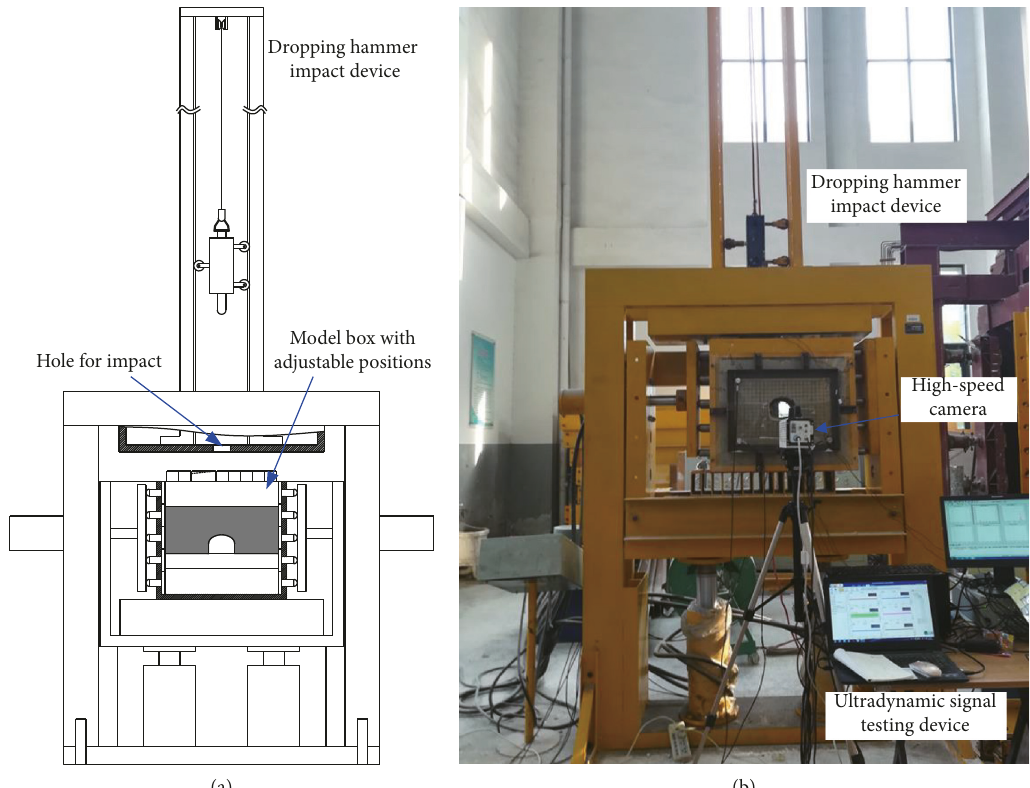
Figure 4: Schematic diagram (a) and an overview of the drop hammer impact test facility